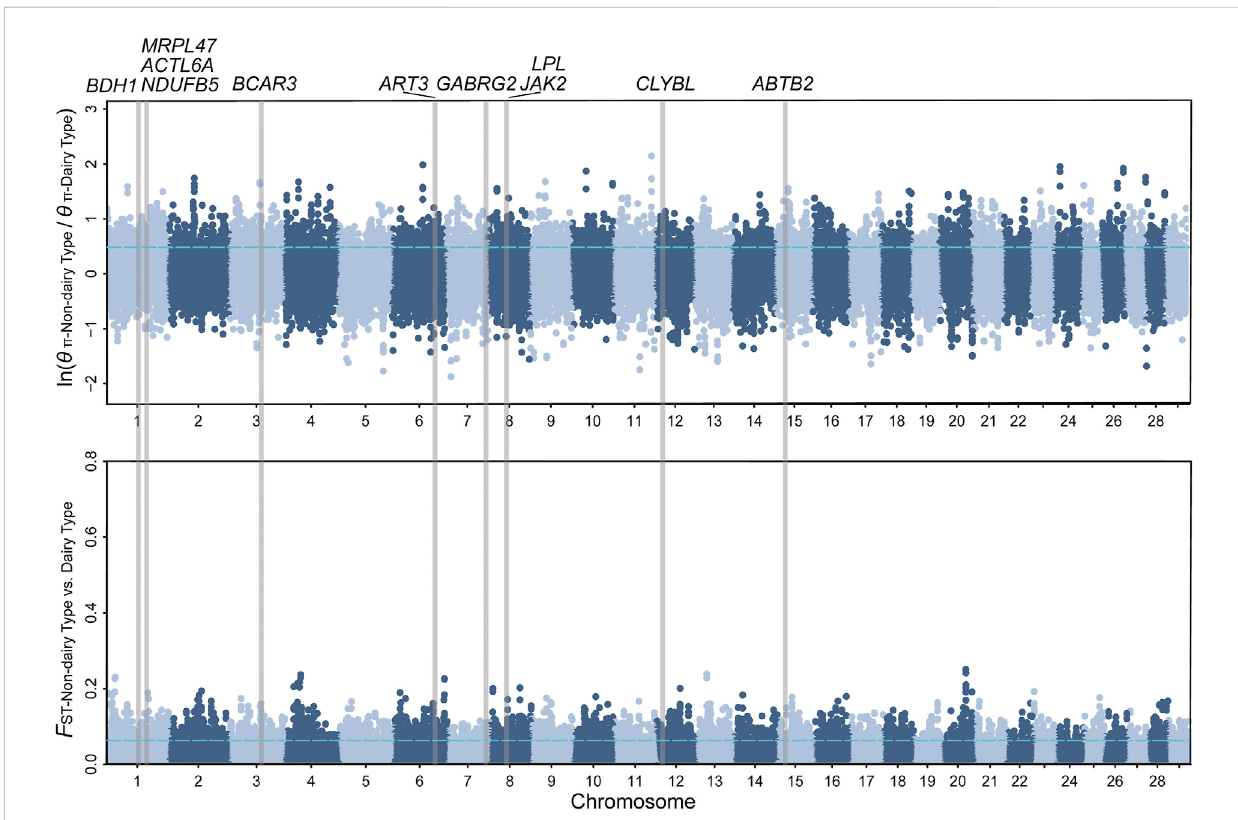
FIGURE 1 Manhattan plot of θ π ratios and F ST for milk traits. The vertical gray thick lines indicated the position of selected genes detected in our study. The values of the top 5% threshold ( F ST = 0.063, θ π ratio = 0.488) are denoted by blue horizontal dashed